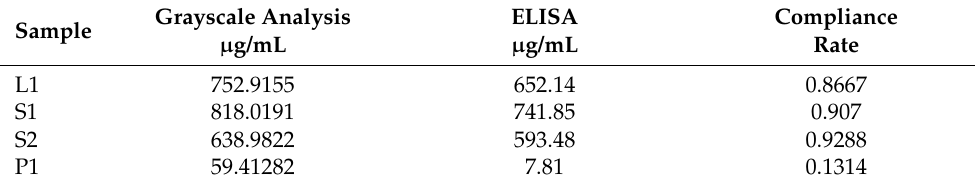
Table 4. The compliance rate of four CPV2 VLPs final products.